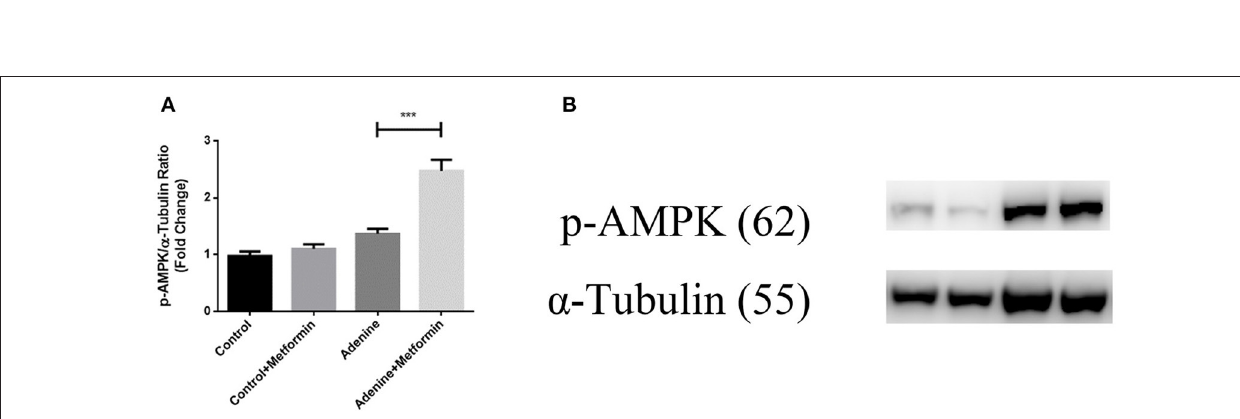
Frontiers in Cell and Developmental Biology |